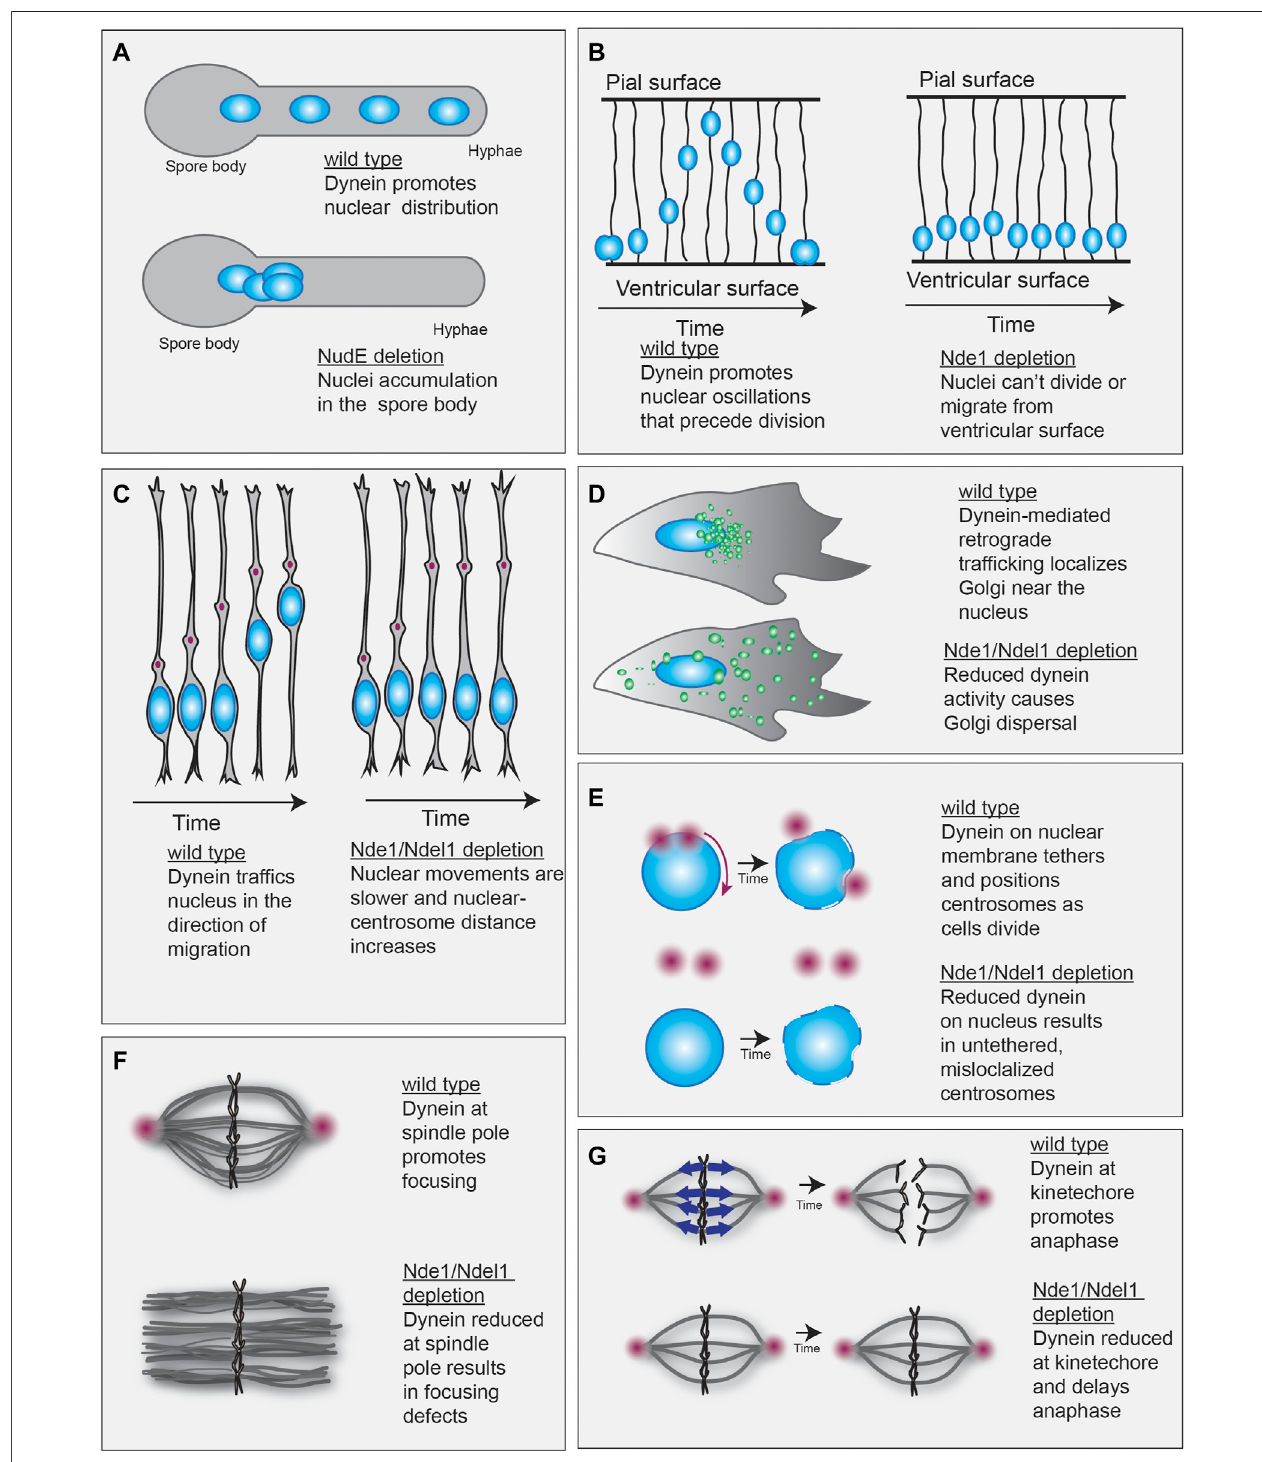
FIGURE 3 | Evidence of a role for Nde1/Ndel1 in dynein-mediated transport. (A) Dynein supports localization of nucleus (blue spheres) along the hyphae in fi lamentousfungi(top).NudEorro-11depletioncausesnucleitoaccumulateinthesporebody(bottom)(Brunoetal.,1996;Minkeetal.,1999;E fi movandMorris,2000). (B) Dynein drivesthe ventricular-directed movement ofnuclei in neural progenitors. These oscillationsare required for cell division (left). Nde1 depletion prevents nuclear oscillatory motions, likely by inhibiting mitosis (right) (Doobin et al., 2016). (C) After division, neural progenitor cells migrate away from the ventricular zone. During this type of migration, the centrosome (red) is oriented in the direction of migration and its forward movement precedes nucleokinesis (left). Nde1/Ndel1 depletion